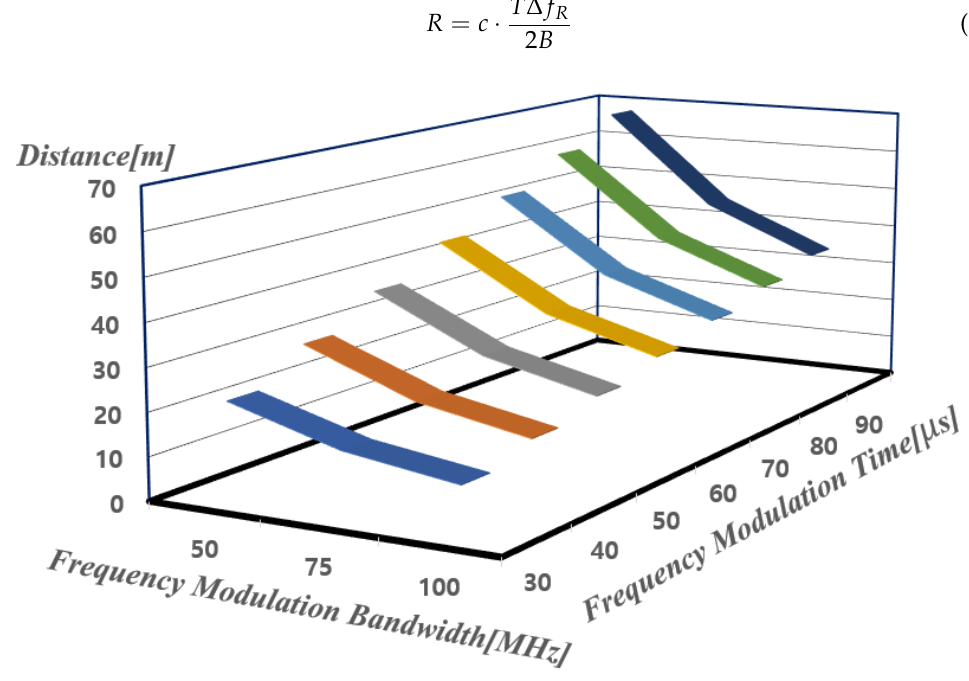
Figure 3. Target range calculation according to frequency modulation time ( T ) and frequency modulation bandwidth ( B ) with ∆ f R =